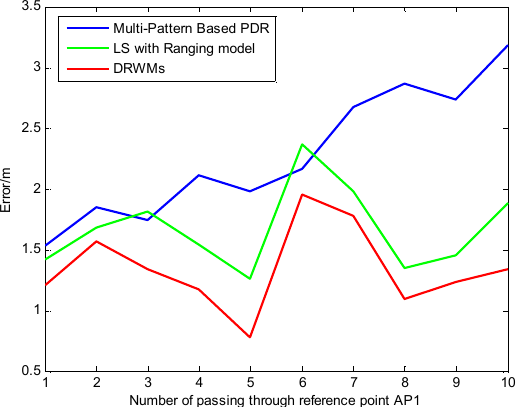
Figure 15. Long-term estimation in first experimental site.